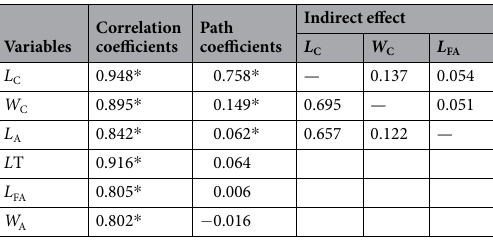
Table 1. Path coefficients for measured characters in P. clarkii . Total length ( L T ), carapace length ( L C ), abdominal segment length ( L A ), first abdominal segment length ( L FA ), abdominal segment width ( W A ) and carapace width ( W C ); ∗ Significant at the 0.05 probability